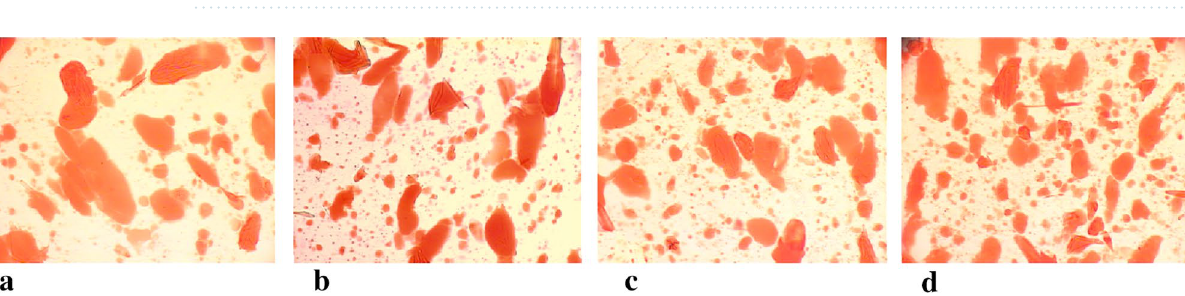
Figure 3. Microstructure of batter (x200) (fat globules) after 8 min chopping produced with varying rotational speed of chopper knives and bowl: ( a ) −1500/10 rpm −1 , ( b ) −1500/20 rpm −1 , ( c ) −3000/10 rpm −1 , ( d ) −3000/20 rpm −1 .